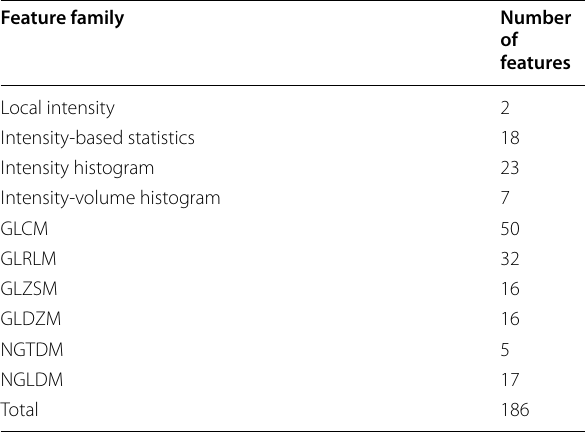
Table 1 Number of radiomics features per region and their family